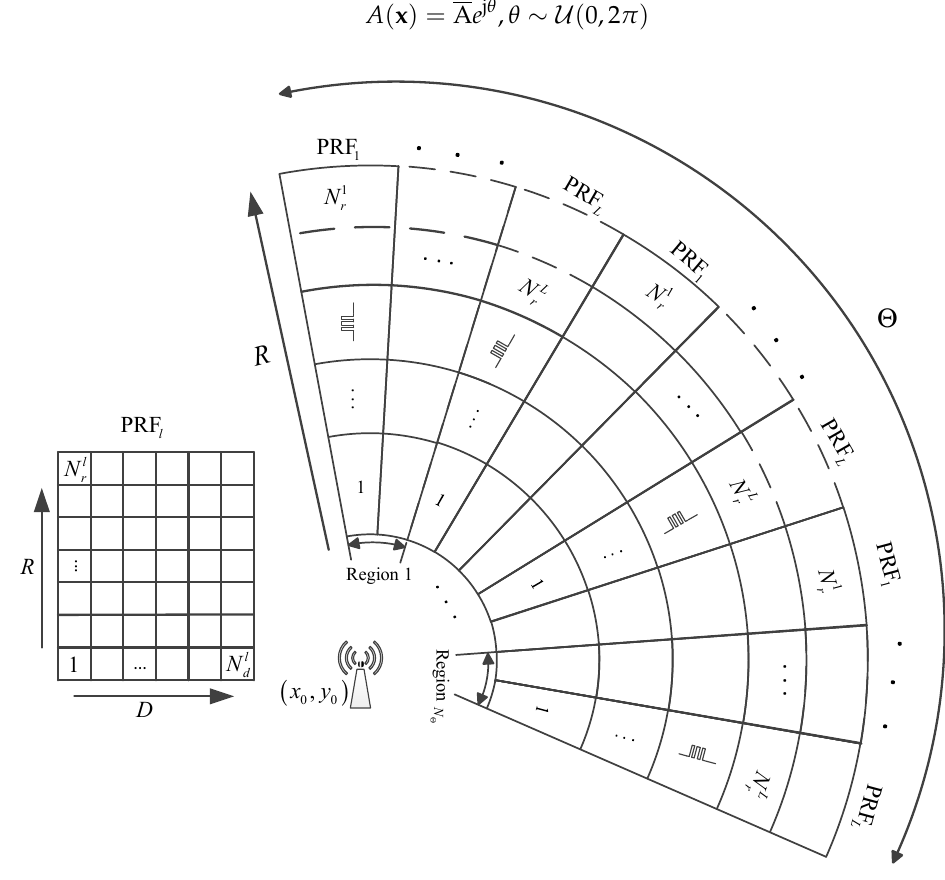
Figure 1. The pixel-imaged observation model in three dimensions.